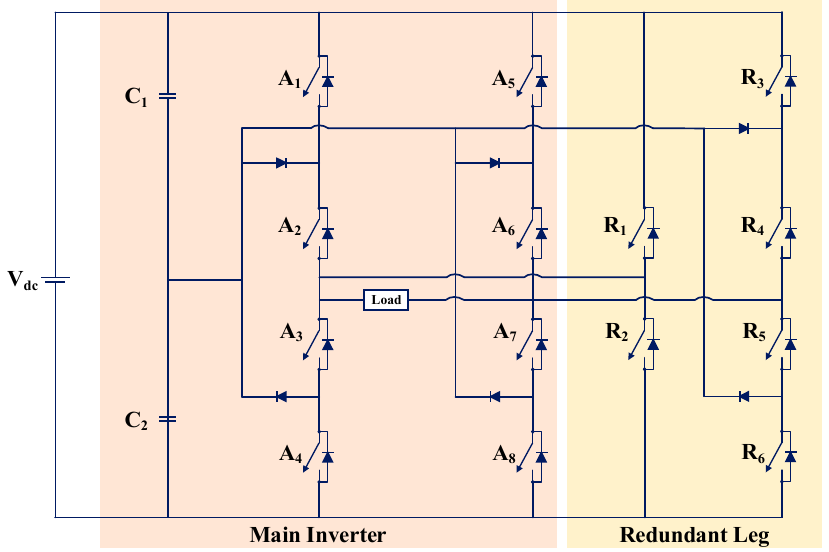
Figure 37. Single-phase five-level FT MLI (TP40) [72].